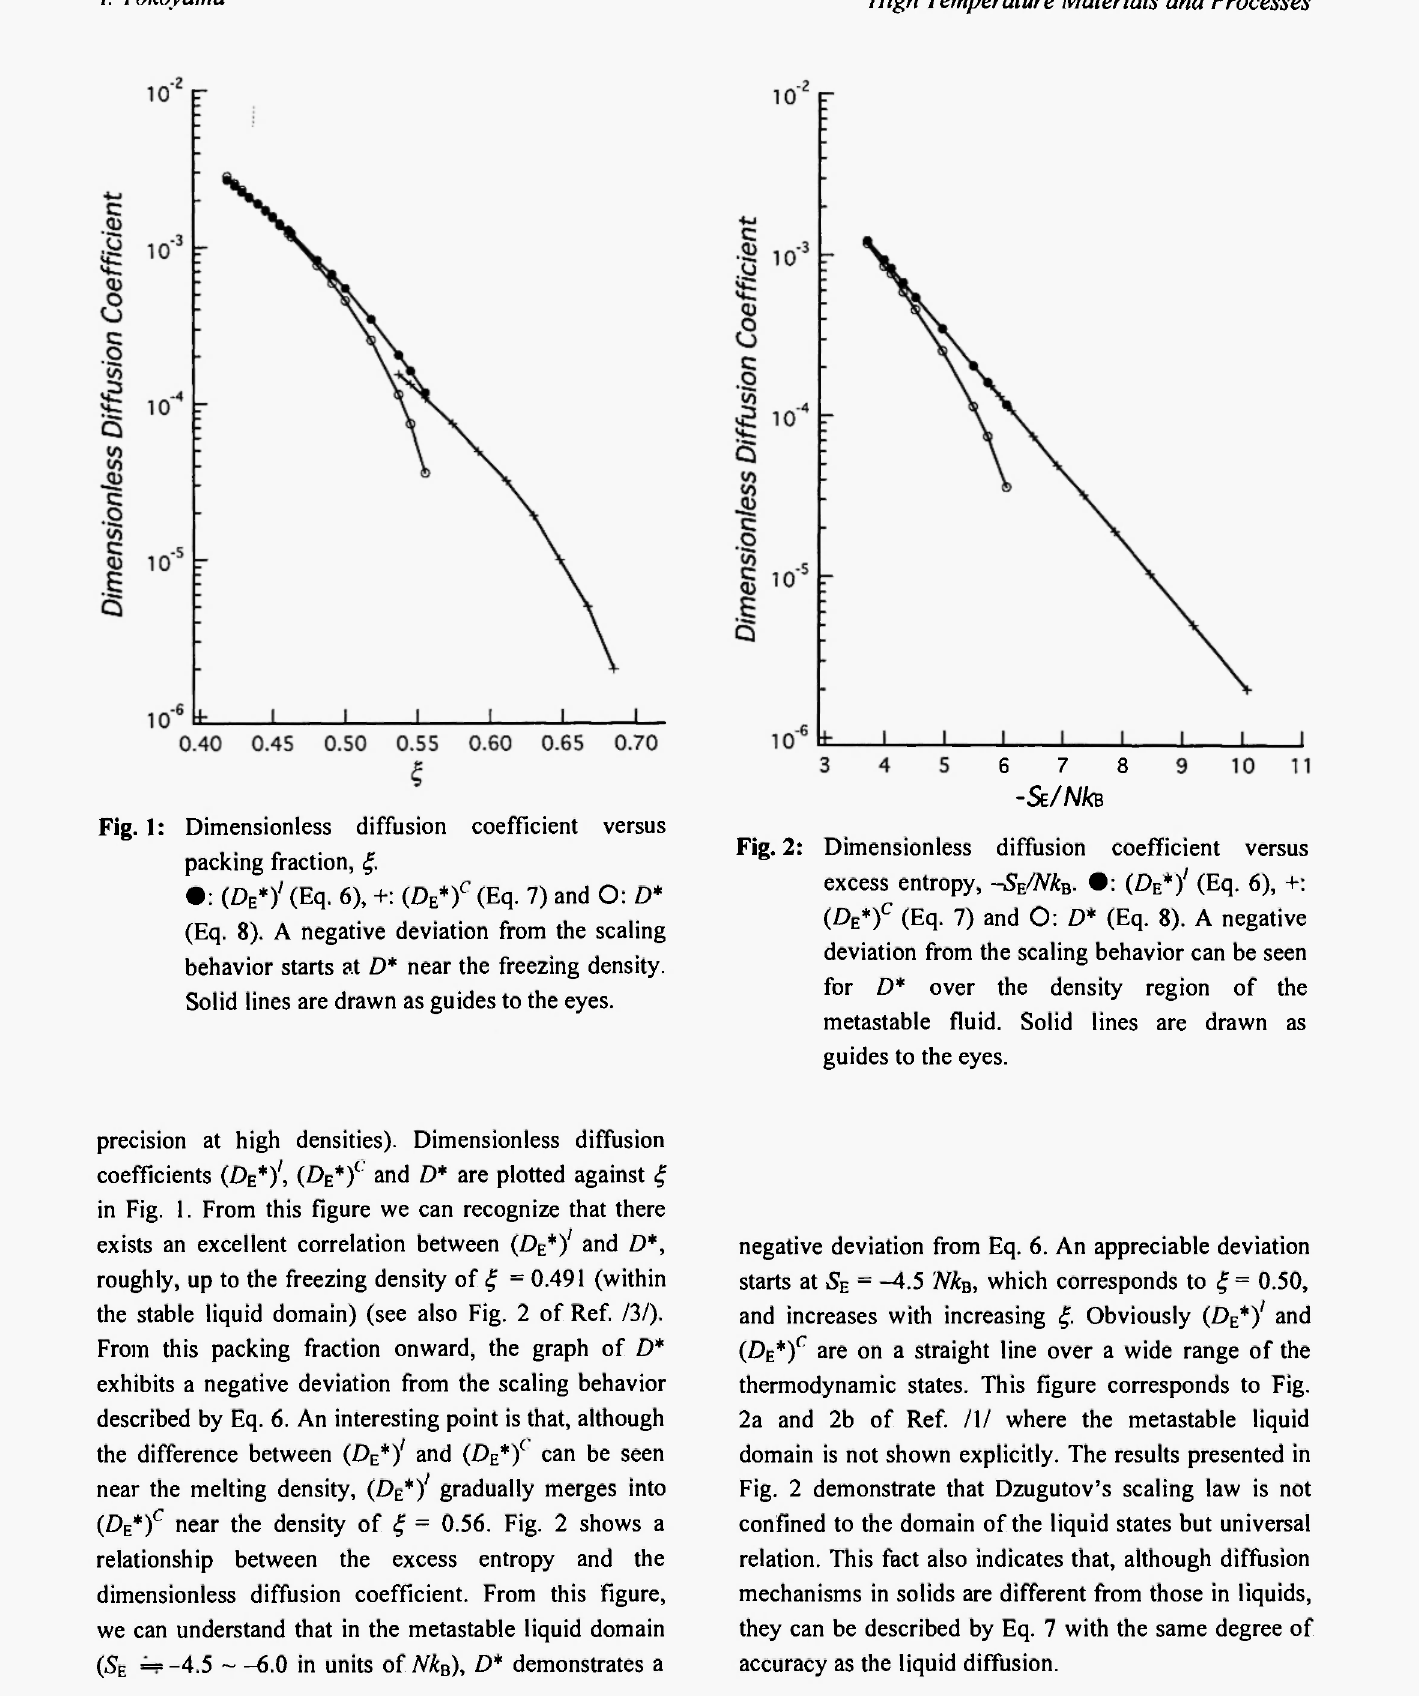
negative deviation from Eq. 6. An appreciable deviation starts at S E = -4.5 Nk B , which corresponds to ξ = 0.50, and increases with increasing ξ. Obviously (D E *)' and (D e *) c are on a straight line over a wide range of the thermodynamic states. This figure corresponds to Fig. 2a and 2b of Ref. /I/ where the metastable liquid domain is not shown explicitly. The results presented in Fig. 2 demonstrate that Dzugutov's scaling law is not confined to the domain of the liquid states but universal relation. This fact also indicates that, although diffusion the mechanisms in solids are different from those in liquids, they can be described by Eq. 7 with the same degree of accuracy as the liquid diffusion.